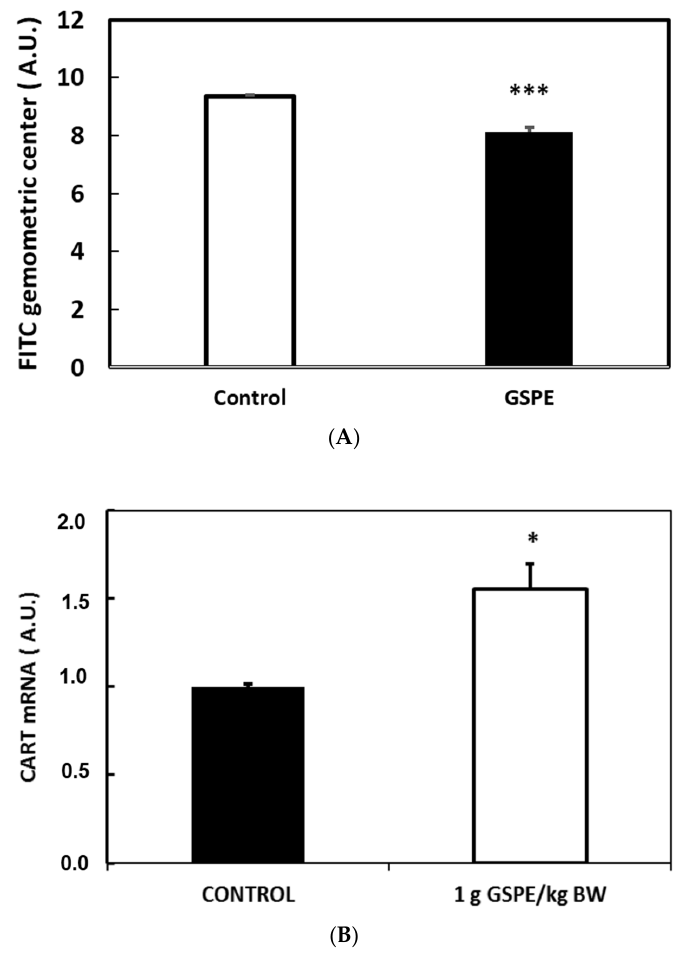
Figure 4. Grape seed proanthocyanidin extract (GSPE) effect on physiological parameters. Wistar rats that received GSPE treatments are indicated as white columns. Control animals are indicated as black columns. ( A ) rats received a chronic treatment with 0.5 g GSPE /kg body weight (BW). Fluorescein isothiocyanate (FITC) was orally forced and FITC in different gastrointestinal localizations was measured after death; ( B ) rats received an acute treatment of 1 g GSPE/kg BW. After death, hypothalamic CART expression was measured. n = 6 per group; * p < 0.05; *** p < 0.001 vs. control group by Student’s t ‐ test.